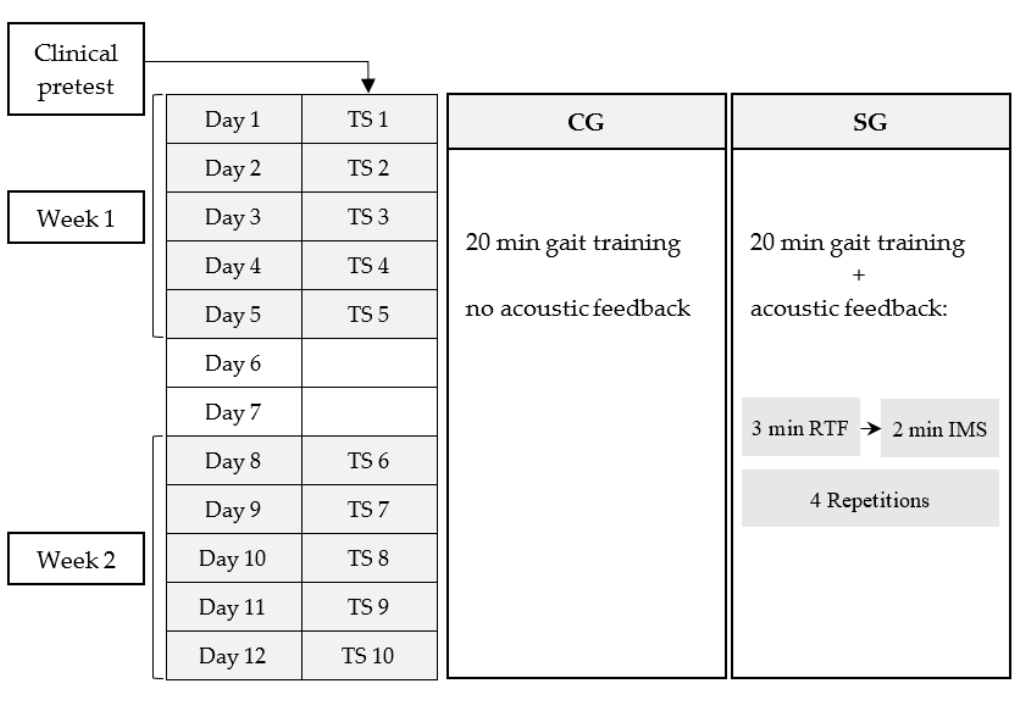
Figure 2. Patient of the sonification group during gait training. The temporal course can be observed on the notebook screen.